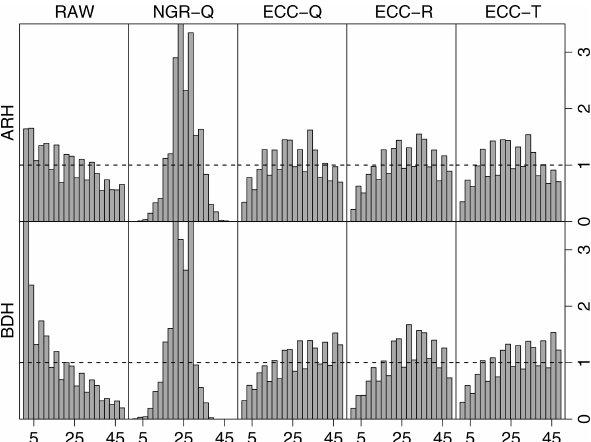
Figure 11. Multivariate rank histograms of the samples of the raw ensemble (RAW), quantile sample of the NGRVC-postprocessed ensemble (NGRVC-Q), quantile sample of ECC (ECC-Q), random sample of ECC (ECC-R) and the transformed RAW sample (ECC- T). Top row: average rank histograms; bottom: band-depth his- tograms. Data include all available stations, all lead times and the 31 pressure levels between 1020 and